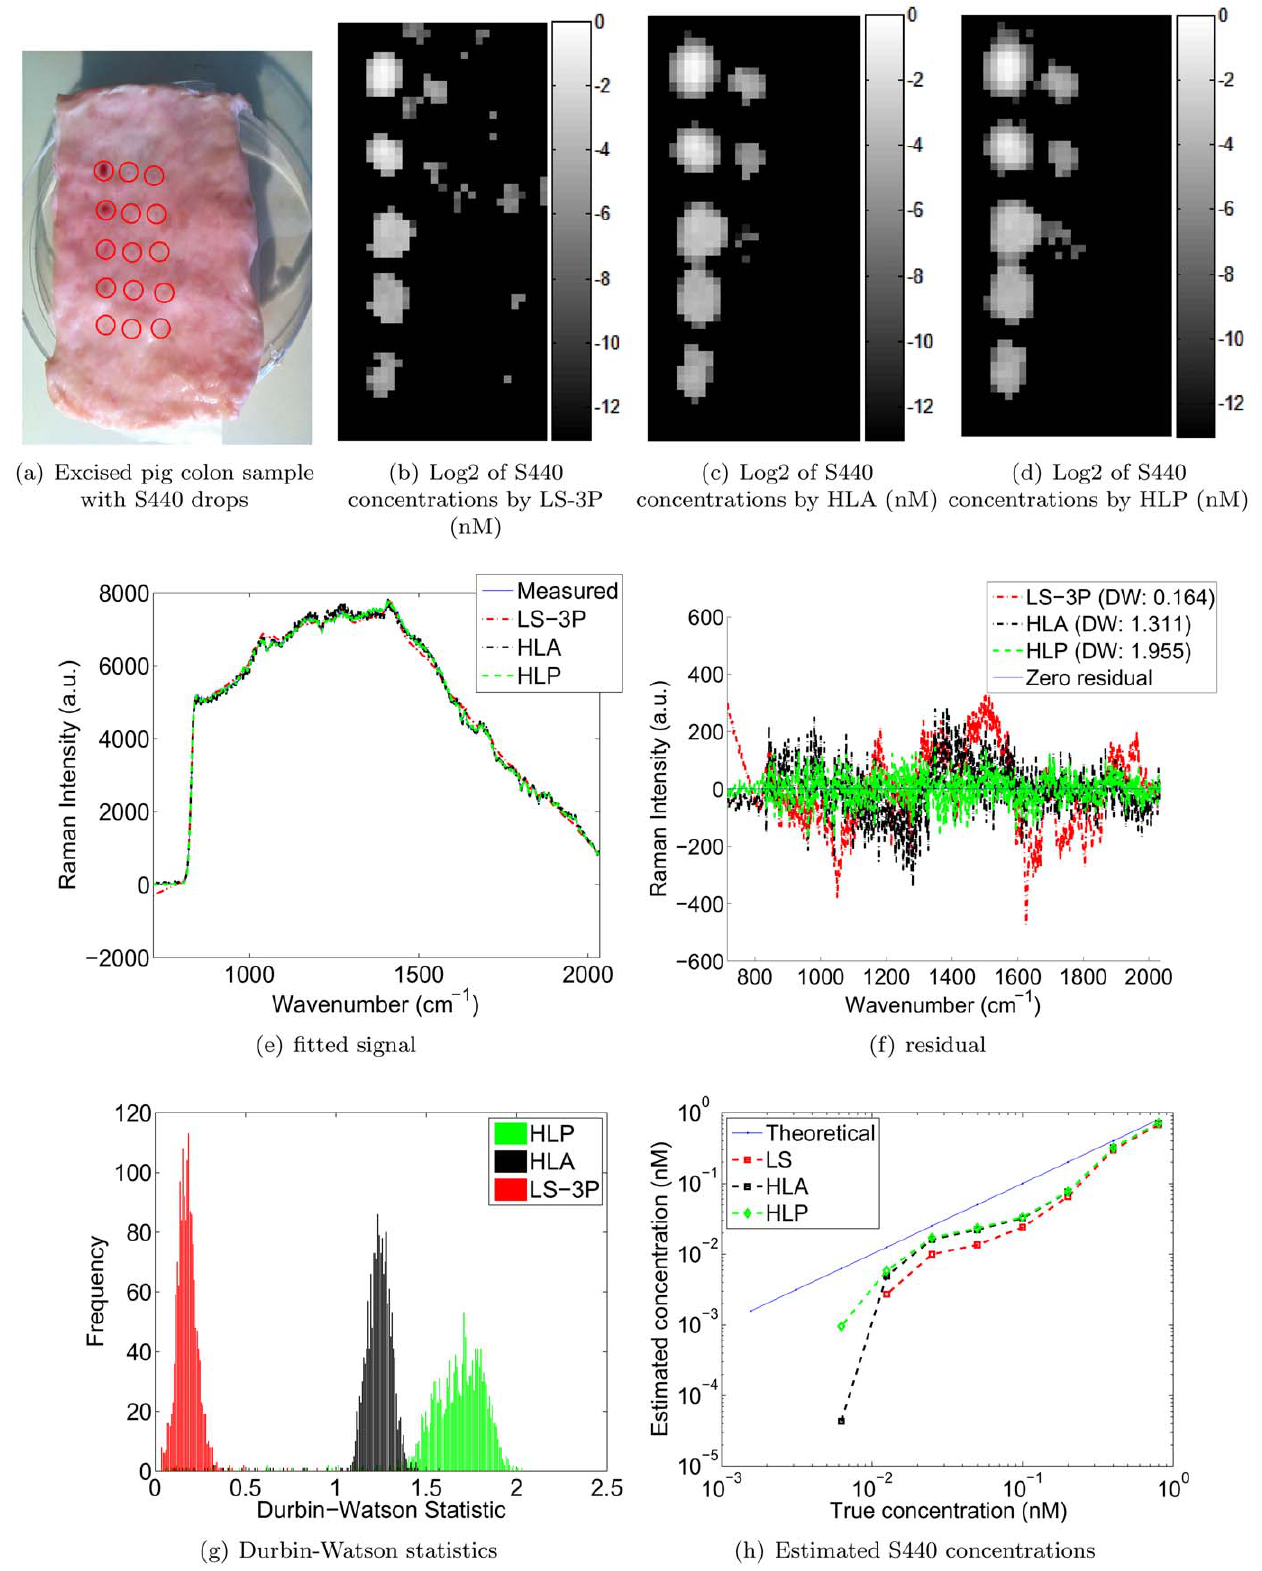
Figure 5. Excised pig colon results.